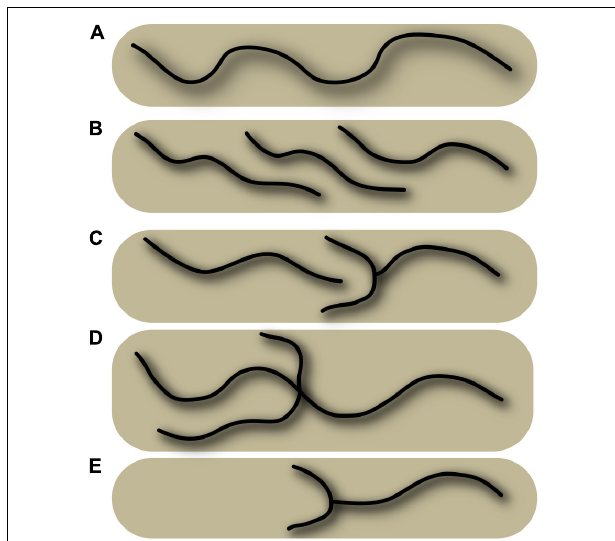
FIGURE 1 | Schematic representation of various configurations of a sulcus, which illustrates the absence of general point-to-point matching between subjects. The schema represents five superior frontal sulci, and some configurations can be observed in real data in Figure 5 . (A) Single, long sulcus configuration. (B) Interrupted sulcus with parallel overlaps. (C) Interrupted sulcus with small branches. (D) Sulcus with a short branch and a long branch, located at a different position from configuration (C) . (E) Shorter sulcus with small branches and a missing part. Superimposing the various situations here, even using non-linear warping, will not provide a perfect